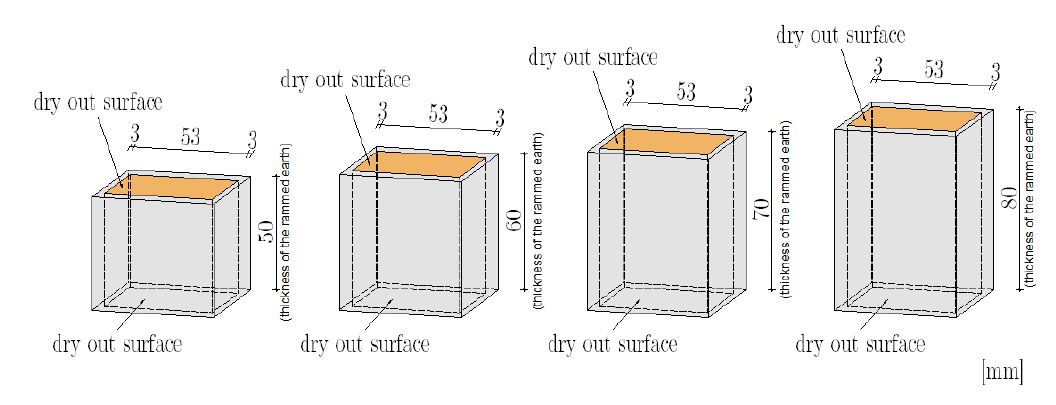
Figure 10. The diagram of the test bodies in the moulds for drying rate experiments.